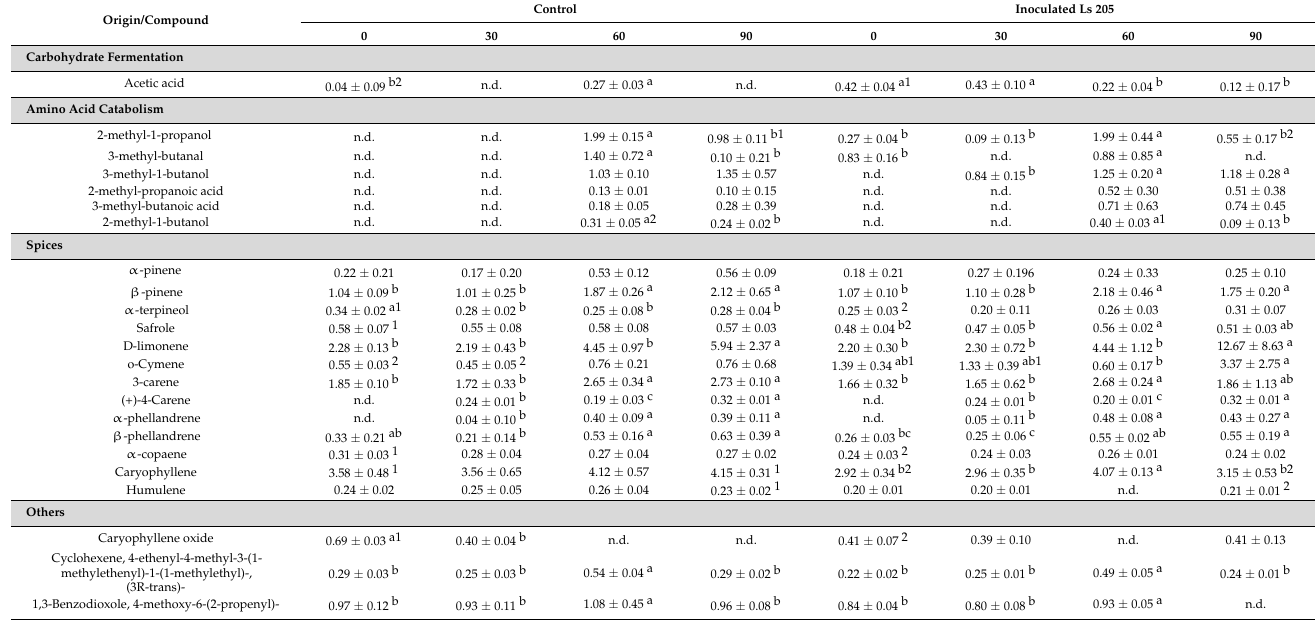
Table 2. Profiles of volatile compounds (carbohydrate fermentation, amino acid catabolism, spices, and others) of Control (uninoculated batch) and Ls (batch inoculated with Lactilactobacillus sakei ) during the ripening process (0, 30, 60, and 90 days) of dry-cured fermented sausages (Arbitrary Area Units × 10 6